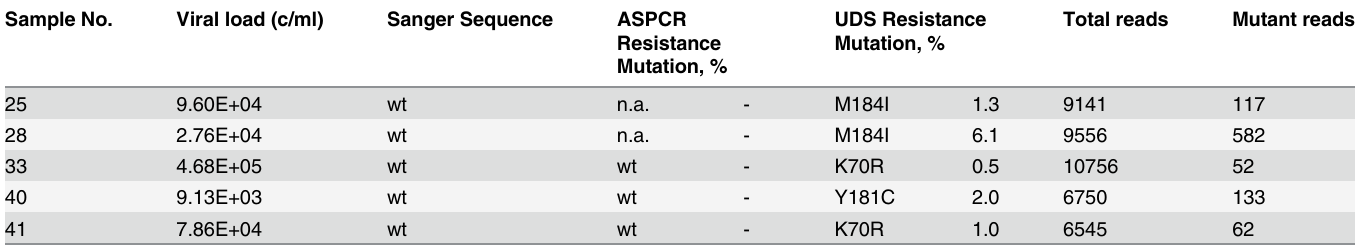
(n = 5) or by NVP and 3TC (n = 2). No multi-resistance (AZT/NVP/3TC) was detected by UDS. Wild-type virus was present in 9/29 women (31%) (Table 4). Based on the ASPCR results, drug-resistance was found to affect 45% (13/29) of women. two women. These mutations resulted in mono-resistance to AZT in 31% (9/29), NVP in